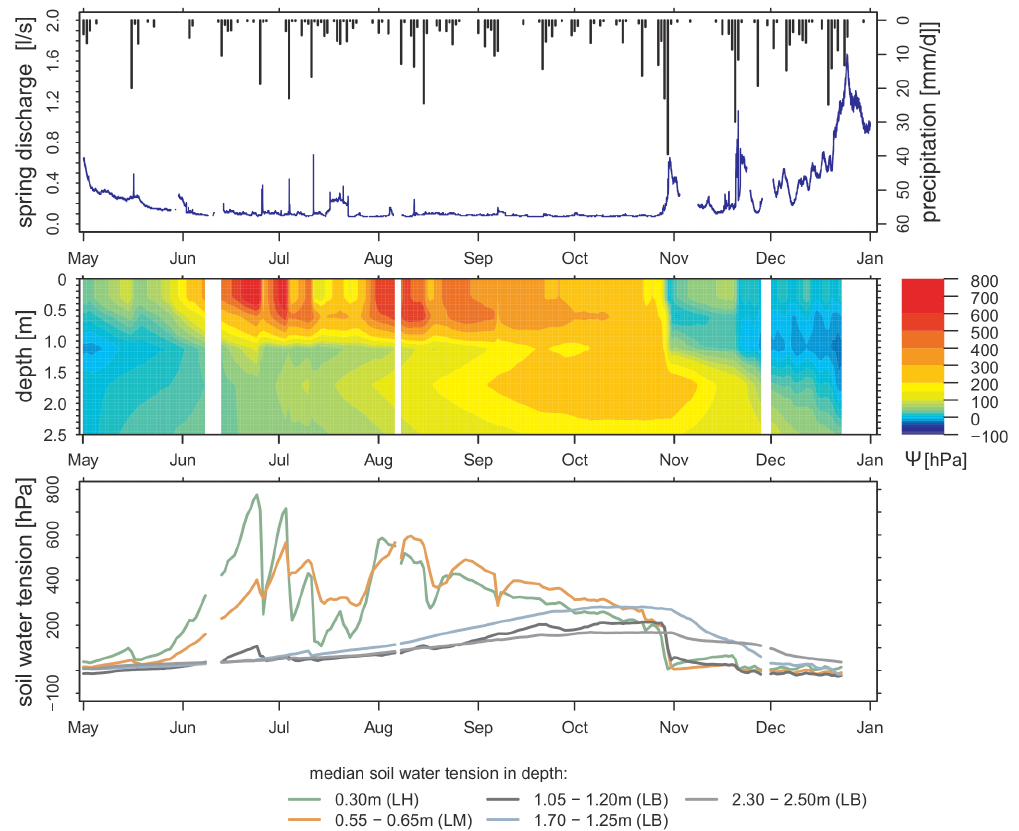
Figure 8. Spring discharge in comparison with daily precipitation (top panel), image of median soil water tension of the shallow subsurface (middle panel) and median soil water tension for different depths (bottom panel) – adapted from Heller (2012).